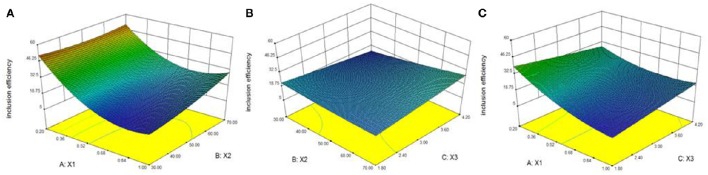
Response surface plots showing effects of material inputting ratio (X1), reaction temperature (X2), and reaction time (X3) on inclusion efficiency. The inclusion efficiency of inclusion complex increased when X1 and X3 decreased while X2 increased. (A) Effects of X1 and X2 on inclusion efficiency. (B) Effects of X2 and X3 on inclusion efficiency. (C) Effects of X1 and X3 on inclusion efficiency.